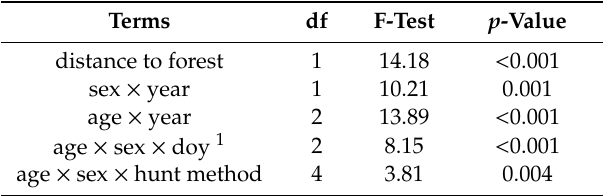
Table 1. The significance of tested e ff ects on the body mass of culled wild boar. df—degree of freedom. Terms